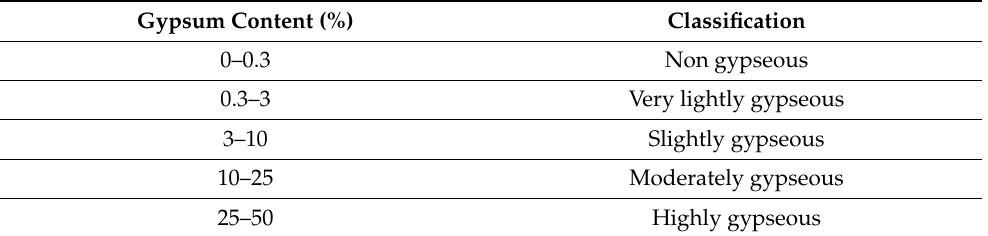
Table 2. Gypseous soil classification